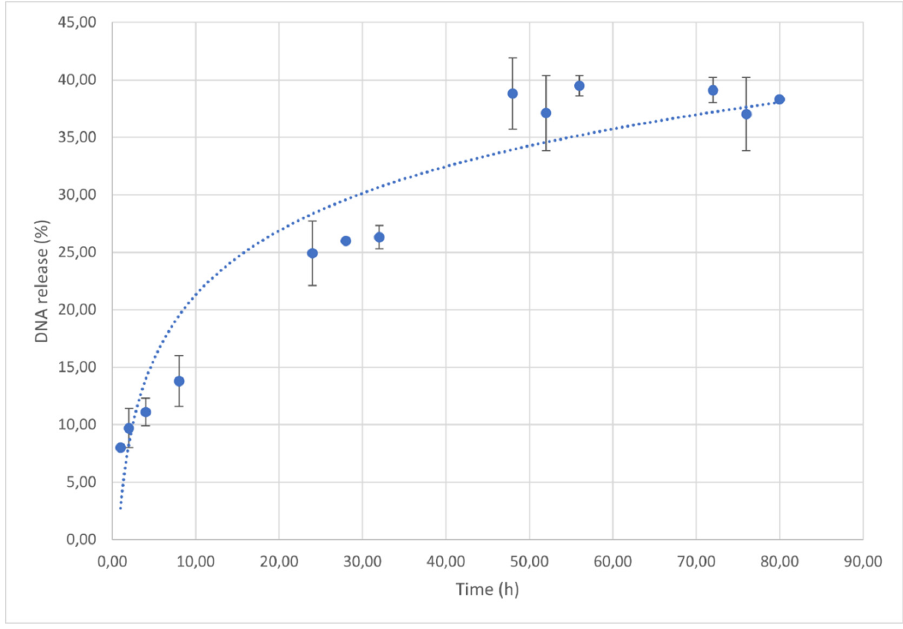
Figure 4. In vitro release kinetics of hsDNA from CS/hsDNA complexes. N/P ratio = 10, CS MW = 50 kDa.